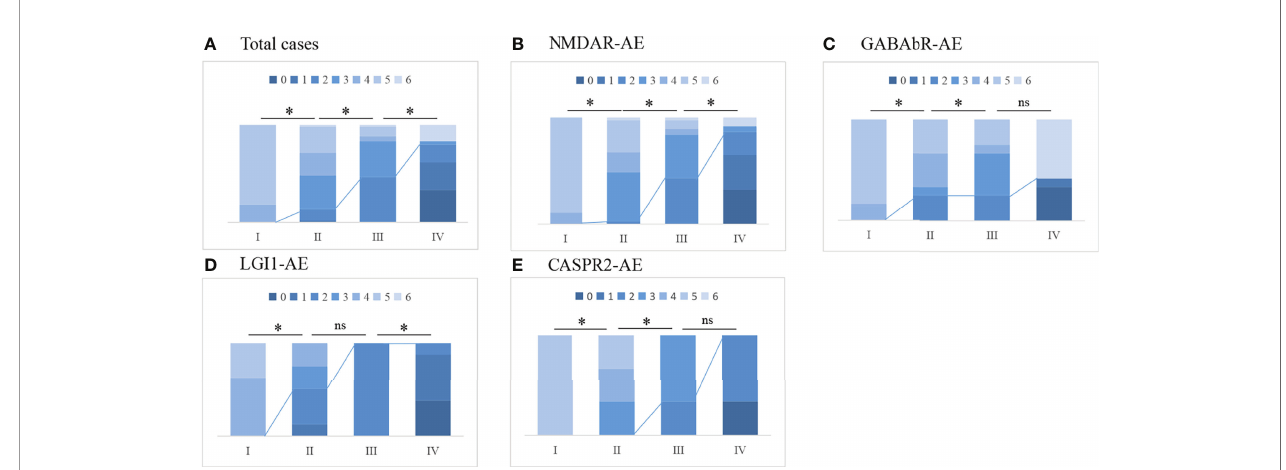
FIGURE 4 | The change in mRS scores and the outcome of total cases (A) and different subtypes of AE (B – E) . I, maximal mRS at symptom onset; II, mRS post- fi rst-line immunotherapy; III, mRS at discharge from hospital; IV, mRS at last follow-up. The line represents the change in mRS scores dividing favorable mRS scores (0 – 2) and unfavorable mRS scores ( ≥ 3); *p < 0.05. ns, not signi fi